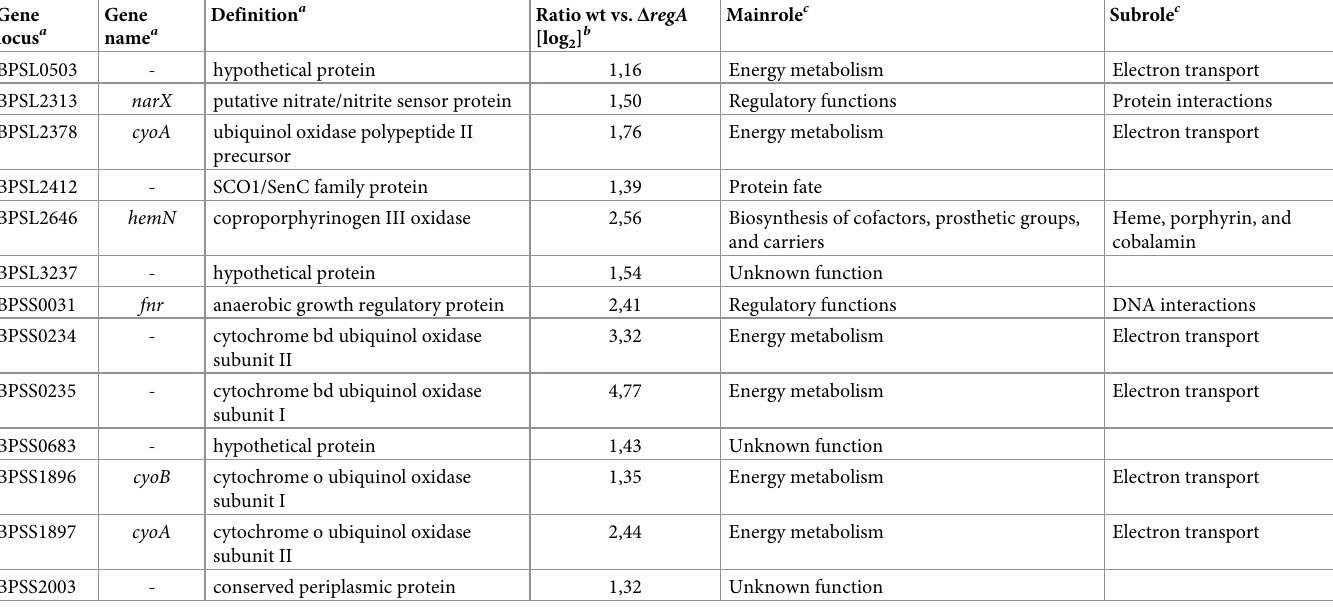
Table 1. Expression analysis of RegA-dependent genes upon normoxic